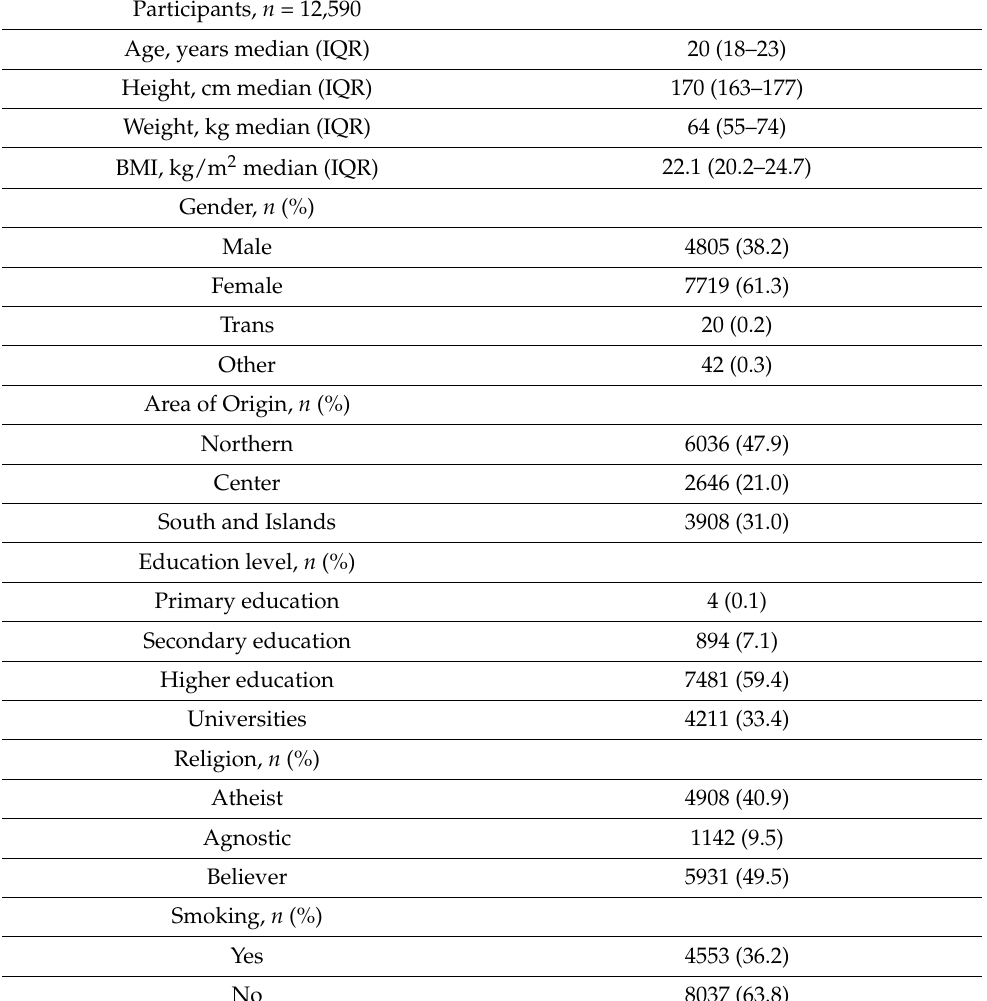
Table 1. Basic characteristics of the participants of our